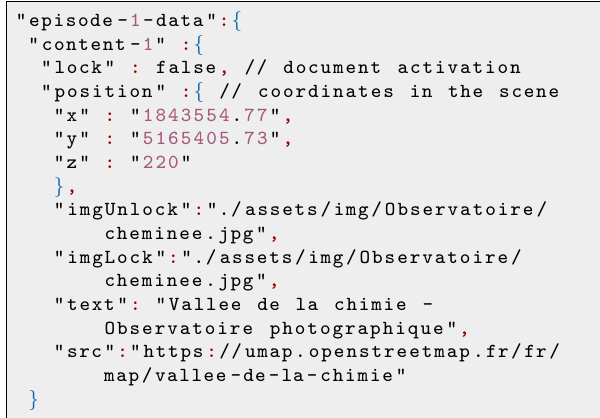
Figure 7. An example of a JSON configuration file used for the 3D geo-pinned multimedia.